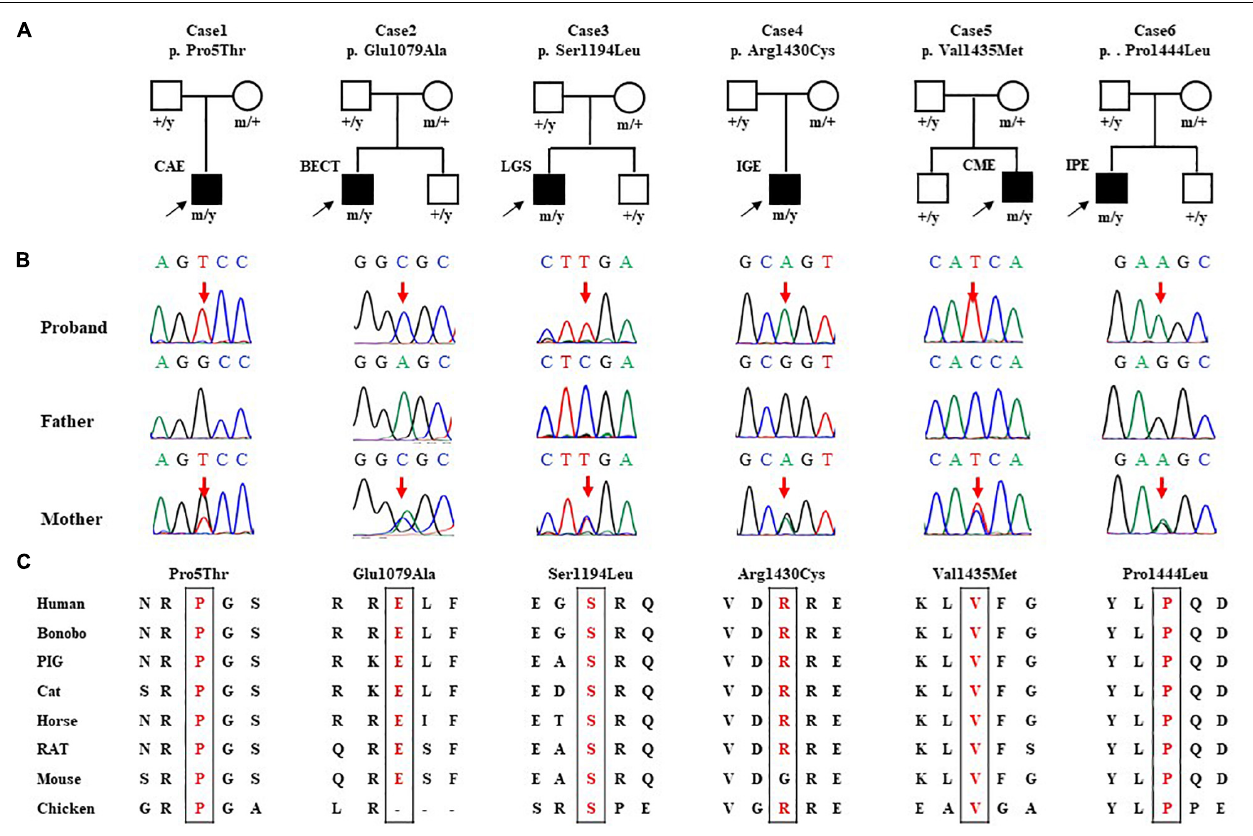
FIGURE 1 | Genetic data of cases with SHROOM4 variants. (A) Pedigrees of the six cases with SHROOM4 mutations and their corresponding phenotypes. (B) DNA sequence chromatogram of the SHROOM4 mutations. Arrows indicate the positions of the mutations. (C) The amino acid sequence alignment of the six missense mutations shows that the residues Pro5, Glu1079, Ser1194, Arg1430, Val1435, and Pro1444 are highly conserved across